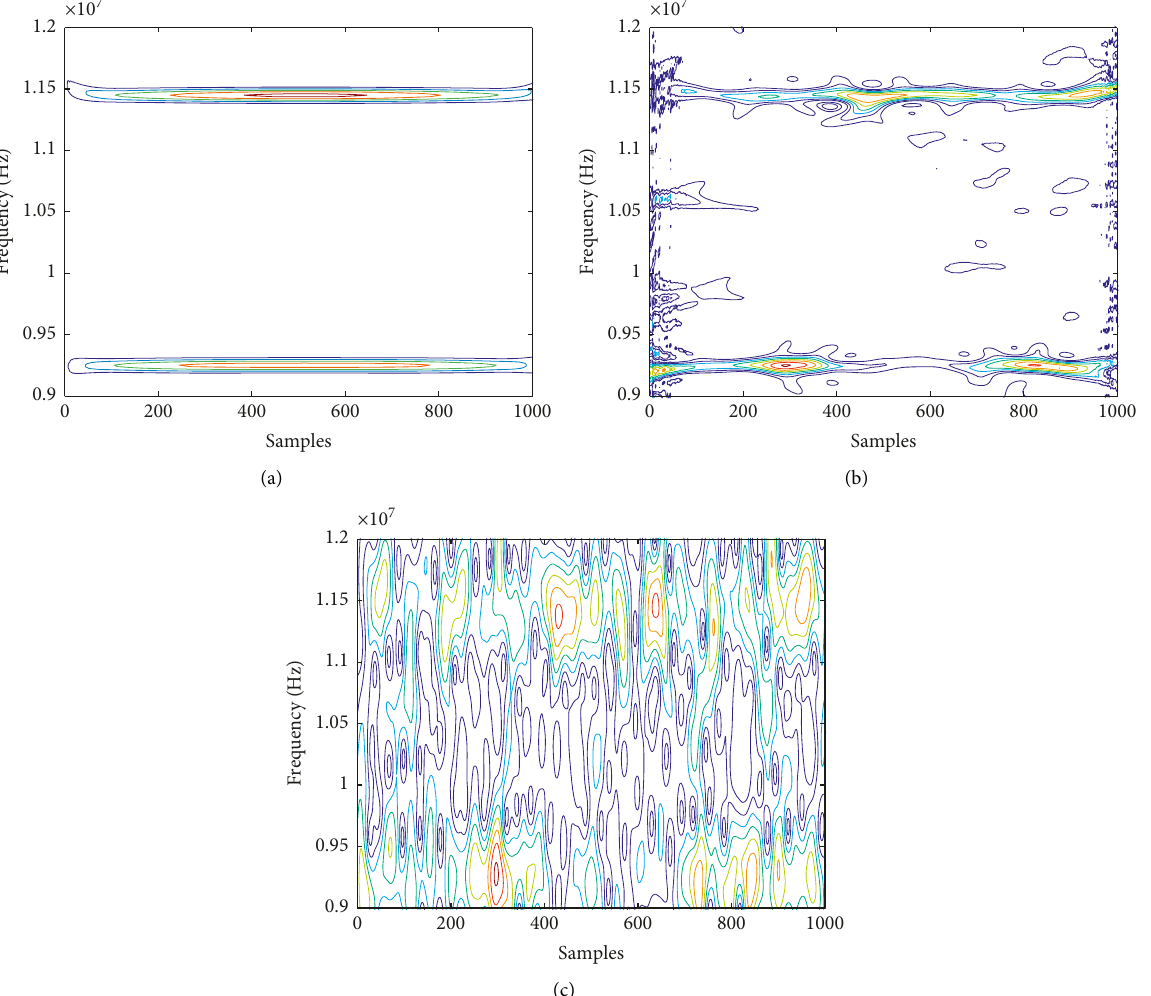
Figure 7: Contour plot for GPS L1 signal in the presence of CW interference. C / N with samples 80. (b) Contour plot using SPWVD with a Kaiser window of samples 80. (c) Contour plot using STFTwith a Kaiser window of samples